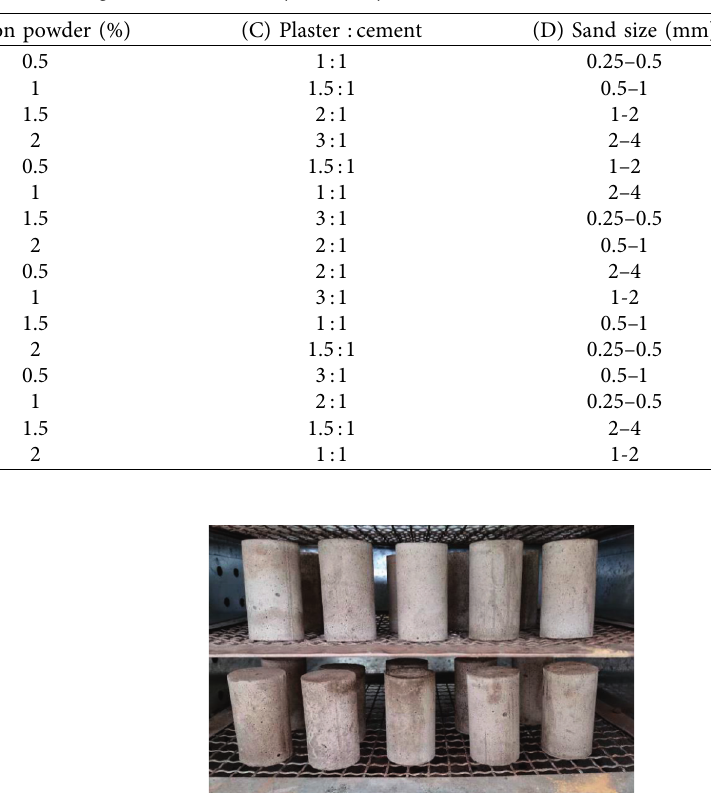
Figure 3: Maintenance of the specimens covered by the